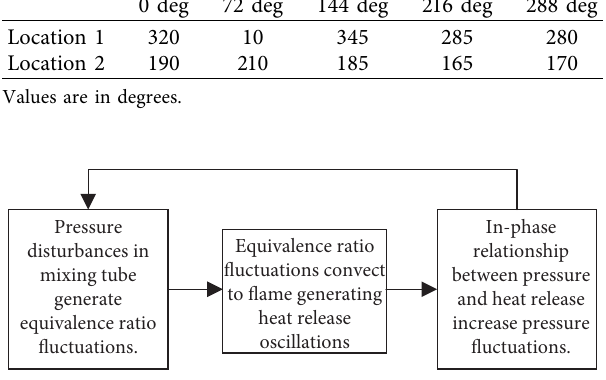
Figure 22: Feedback mechanism for thermoacoustic